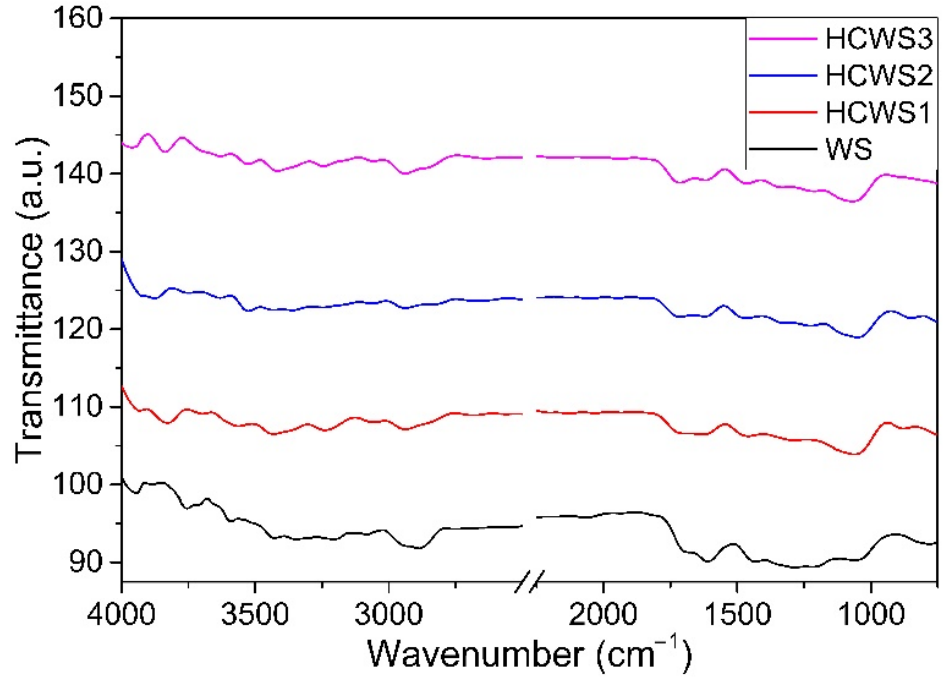
Figure 1. ATR-FT-IR spectra for raw material (WS) and hydrothermal char from walnut shells: HCWS1, HCWS2, and HCWS3, respectively.